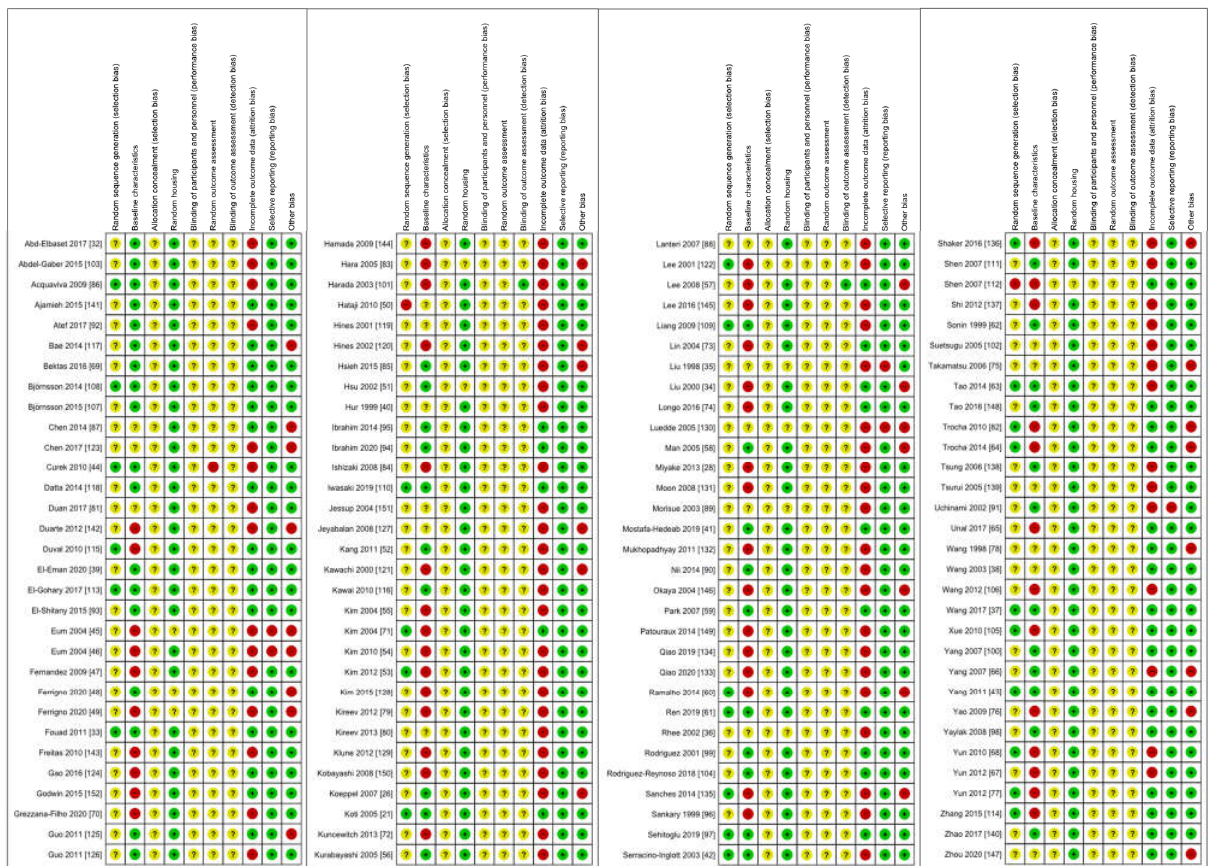
Figure 6. Detailed risk of bias assessment for all 10 signalling questions.